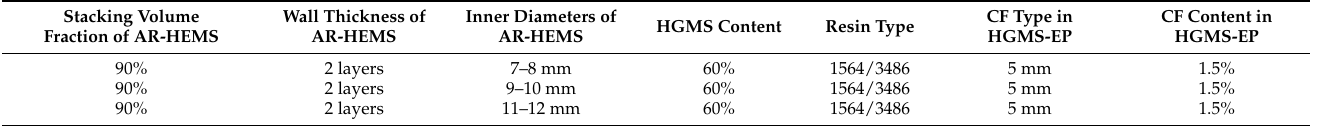
Table 3. Three samples of ESF filled with AR-HEMS with different inner